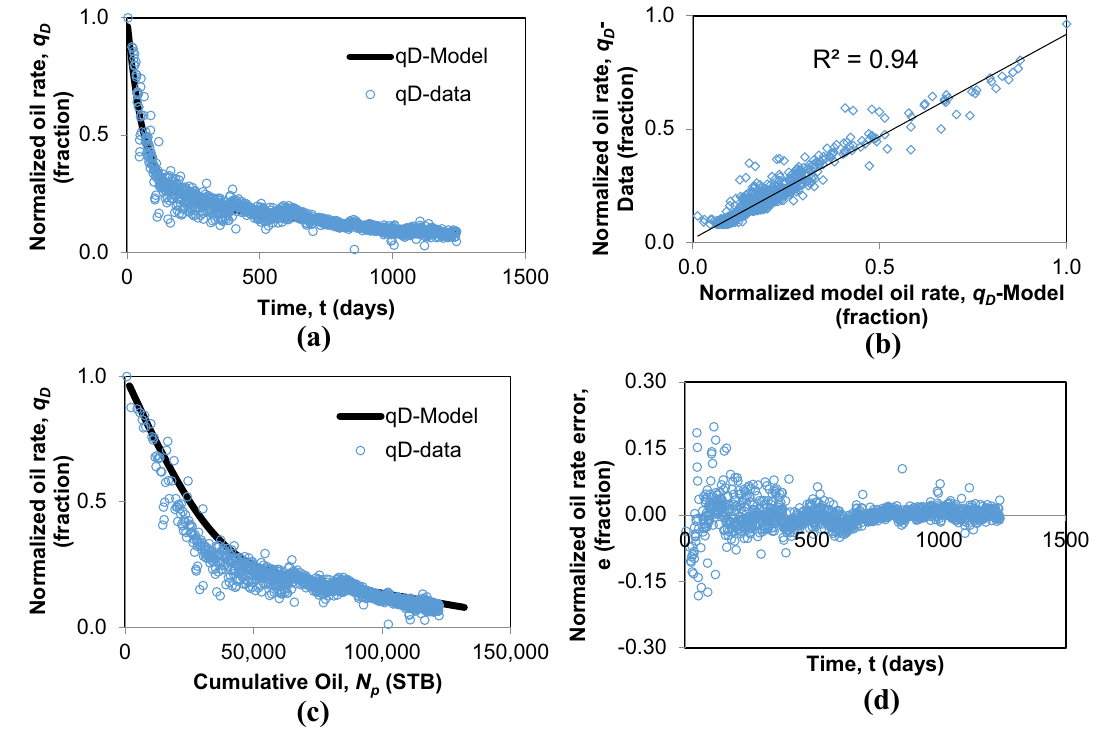
plot of the normalized rate data and the normalized model rate prediction. d Plot of the error in normalized rate prediction ( q D - Data - q D -Model) versus time